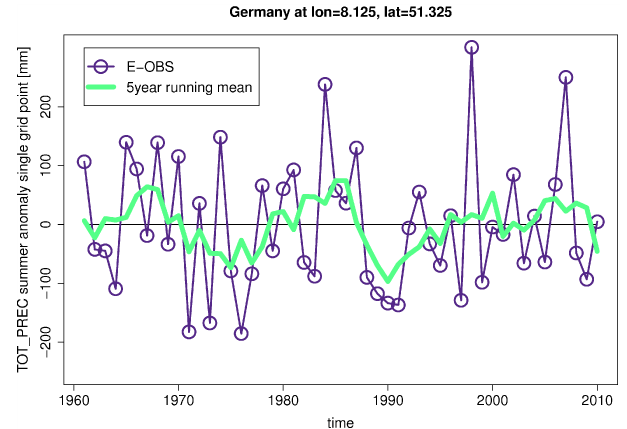
Figure 1. Summer half-year observational (E-OBS) precipitation anomalies at a single grid point in western Germany (circles con- nected with a thin line). The long term mean and trend have been removed by a linear regression. A moving average filter of 5 years is applied to illustrate variability on multi-year time scales (green